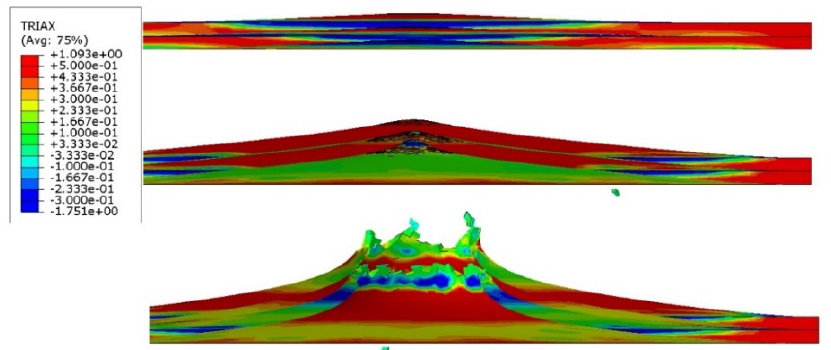
Figure 25. Stress triaxiality visualization in section view during the puncture of two titanium alloy sheets.